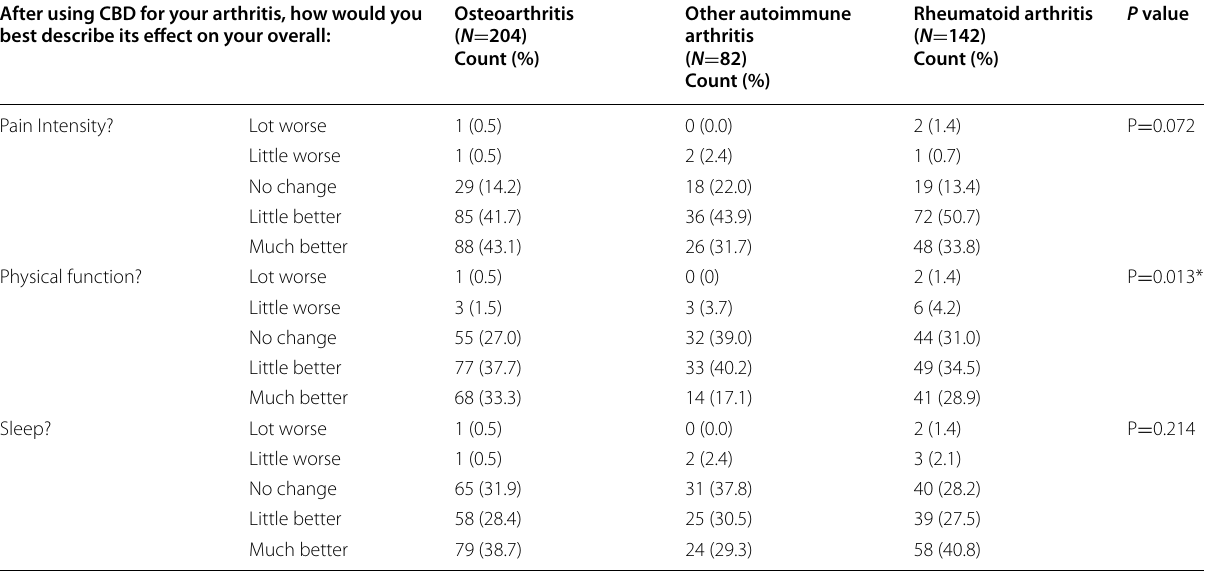
Table 3 Patient Global Impression of Change to evaluate perception of cannabidiol’s (CBD) effect on pain intensity, physical function, and sleep based on type of arthritis